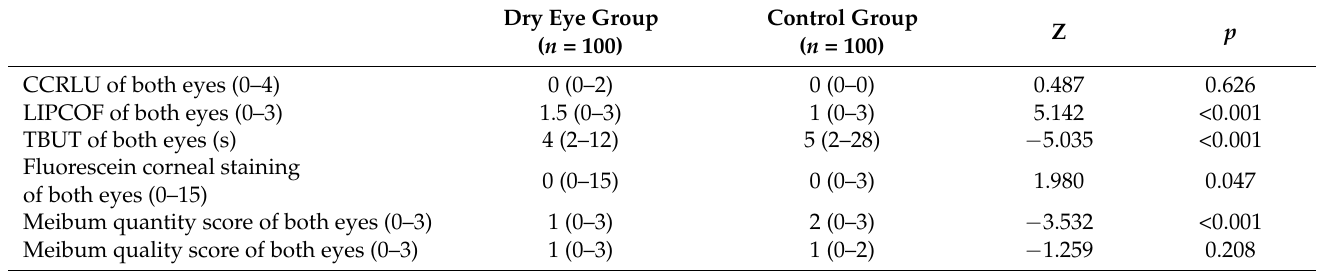
Table 2. The objective dry eye signs and meibum quantity and quality scores after MGX of both eyes in subjects divided into two groups according to the presence/absence of dry eye symptoms.